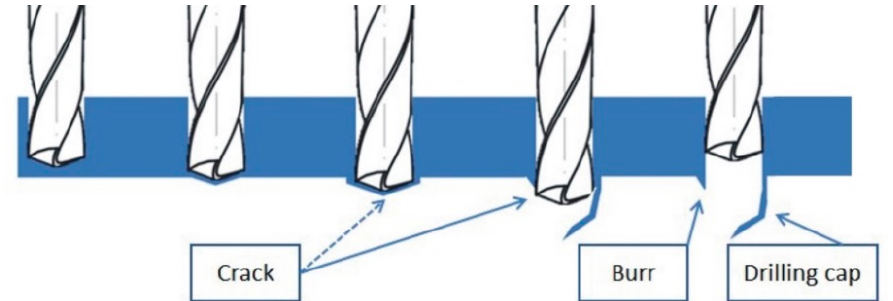
Figure 1. Burr and drilling cap formation scheme.